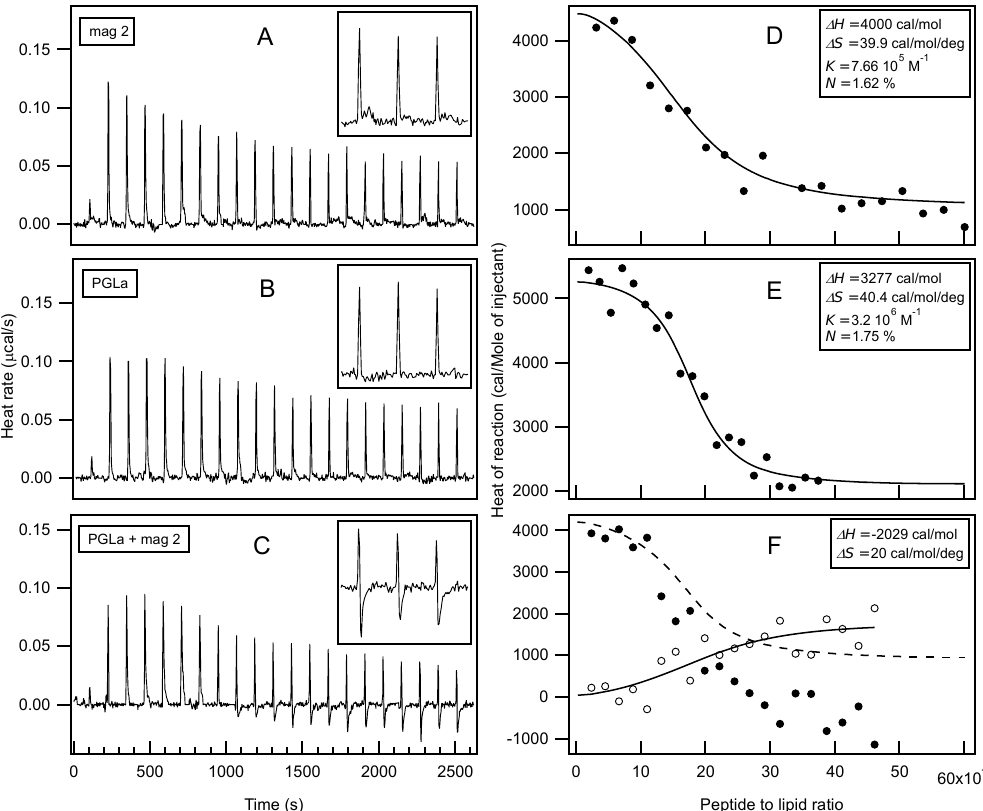
Figure 2. Isothermal Titration Calorimetry measurements of large unilamellar vesicles (LUVs) made of palmitoyl ‐ oleoyl ‐ phosphatidylethanolamine/ palmitoyl ‐ oleoyl ‐ phosphatidylglycerol POPE/POPG (3/1) at 440 μ M total lipid concentration, into which solutions of 85 μ M magainin 2 ( A ), 140 μ M PGLa ( B ), and the equimolar mixture of PGLa and magainin 2 at 105 μ M total peptide concentration ( C ) have been injected successively. Buffer: 10 mM Tris ‐ HCl, pH 7, 100 mM NaCl. The inserts show close ‐ ups of the regions t > 2215 s. The fittings of the data with a single binding site model are displayed as solid lines in panels D – F . The open circles in panel F show the difference of the heat of reactions when comparing the mixture of peptides with the sums obtained from the magainin 2 and PGLa titrations (i.e., half the intensities of the fitted curves shown in panels D and E , dashed line). The values of the enthalpies ( Δ H ), entropies ( Δ S ), binding constant ( K ), and apparent stoichiometry ( N ) are reported in the corresponding graphs.